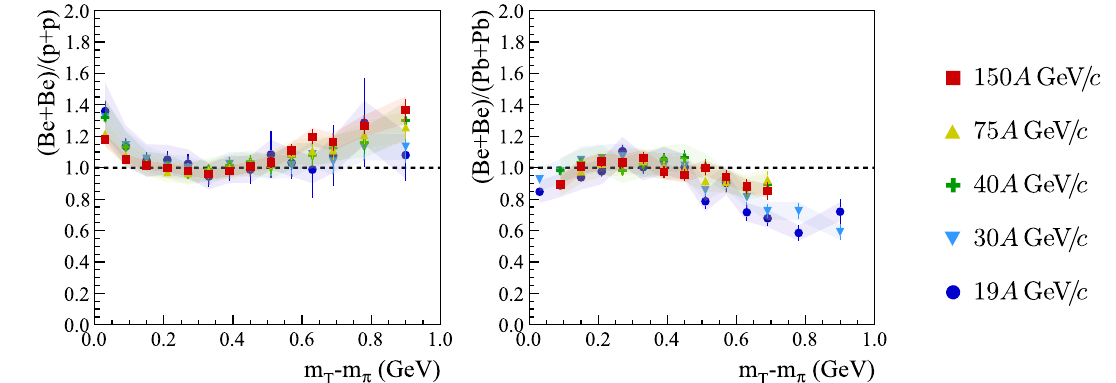
Fig. 1 Ratio of normalized transverse mass spectra: Be+Be/ p+p ( left ) and Be+Be/Pb+Pb ( right ) at the SPS energies